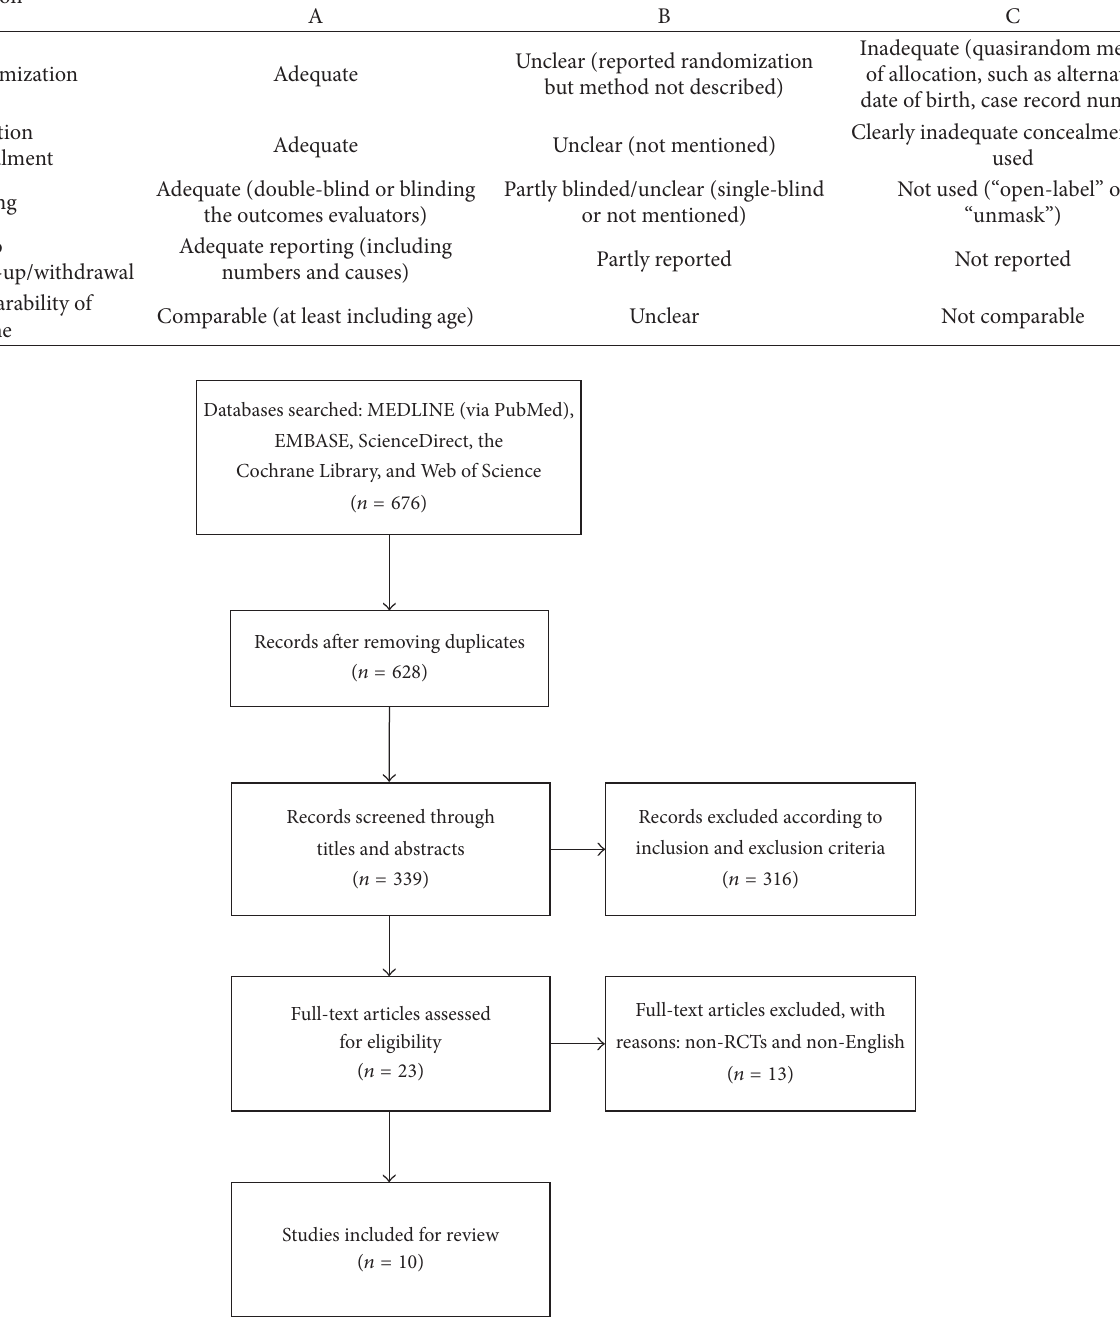
Figure 1: Flow chart showing details of the study selection